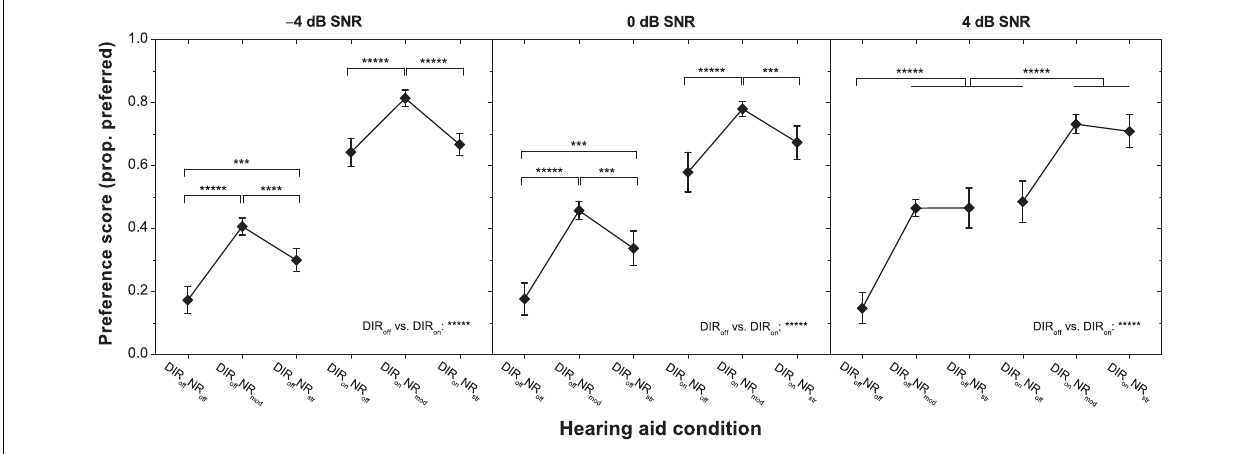
FIGURE 4 | Mean preference scores for the six HA conditions and SNRs of − 4dB (left panel), 0dB (middle panel), and 4dB (right panel). Error bars show 95% confidence intervals. Horizontal bars denote significant differences ( ∗∗∗ p < 0 . 001, ∗∗∗∗ p < 0 . 0001, ∗∗∗∗∗ p < 0 . 00001).